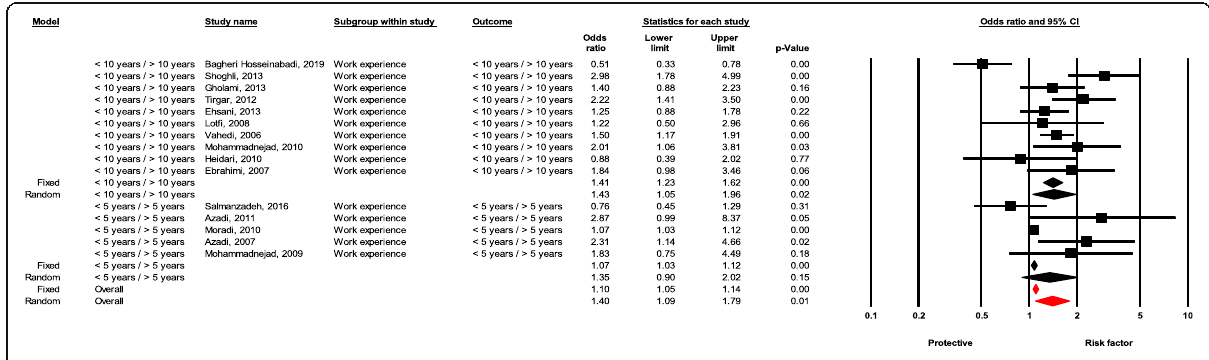
Fig. 12 Forest plot for relationship between Work experience and risk of NSI in Iran